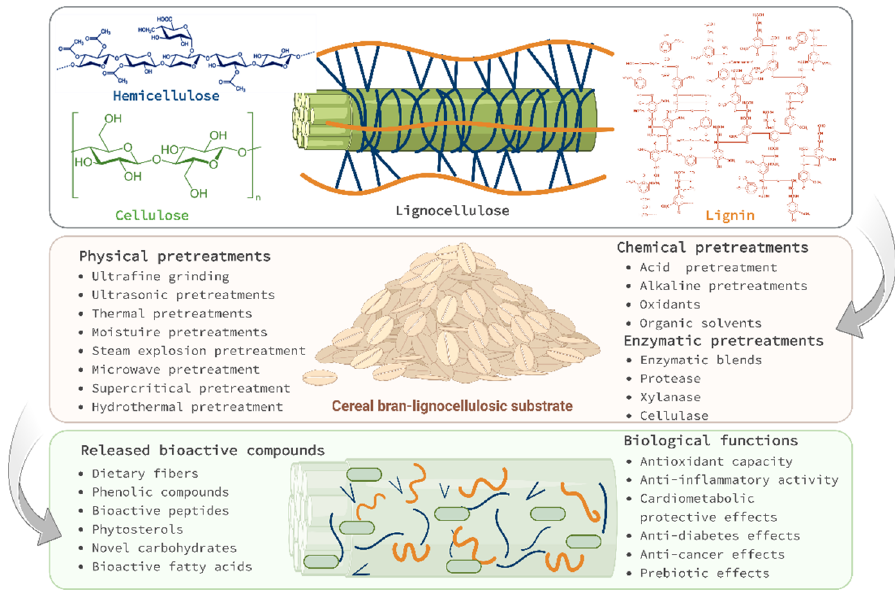
Figure 1. Integrated system to enhance the bioaccessibility of cereal bran phytochemicals.